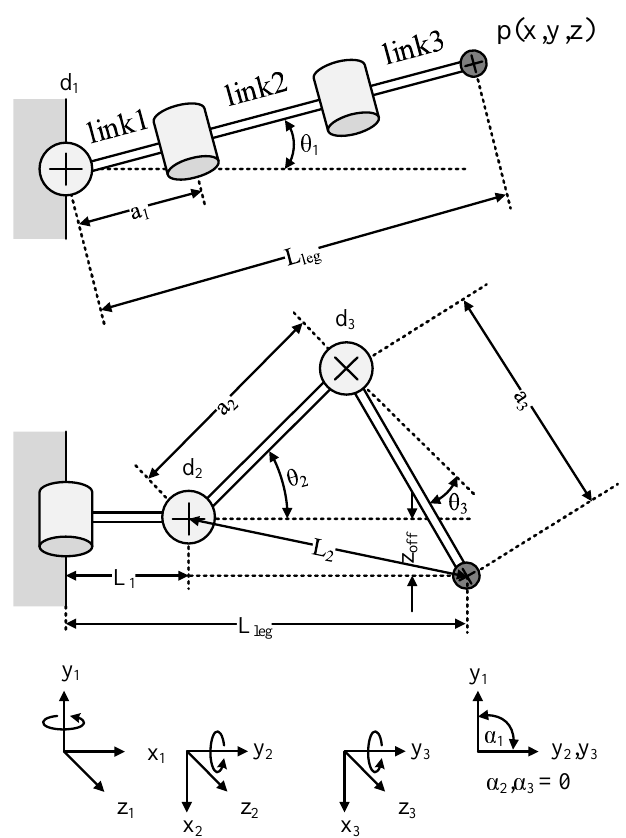
Figure 3. Geometrical model of robot